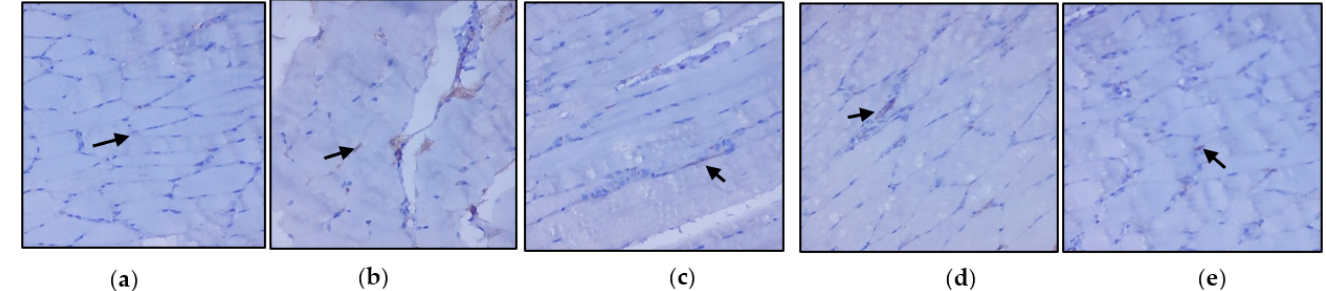
Figure 5. Protein expression of Akt using an immunohistochemical assay (magnification: × 100): ( a ) control rats; ( b ) type 2 diabetic rats; ( c ) type 2 diabetic rats treated with C. papaya (600 mg/kg b.wt); ( d ) type 2 diabetic rats treated with metformin (50 mg/kg, b.wt); ( e ) control rats treated with C. papaya (600 mg/kg b.wt).